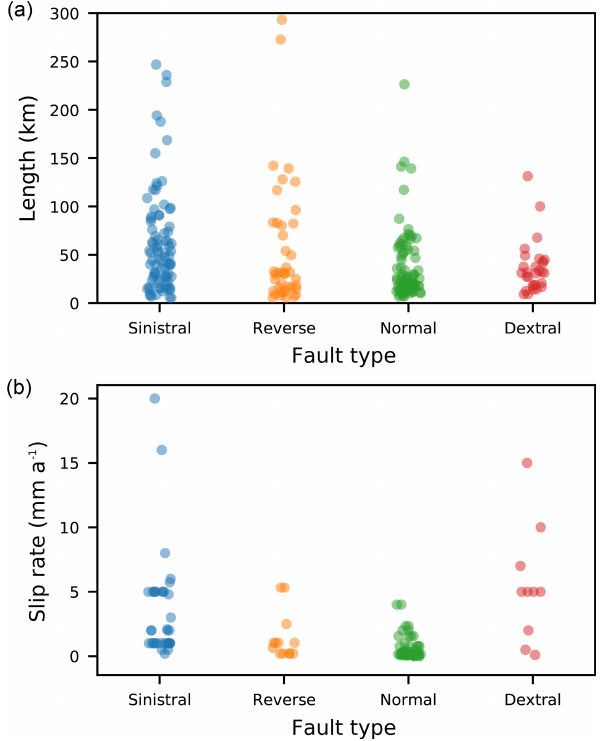
Figure 9. Strip plots of fault length (a) and slip rate (b) for faults in the CCAF-DB, by major fault type (i.e., “dextral–normal” would be considered “dextral”), discounting oceanic plate boundaries. The scatter in the x axis is simply jitter to minimize overprinting of sym-